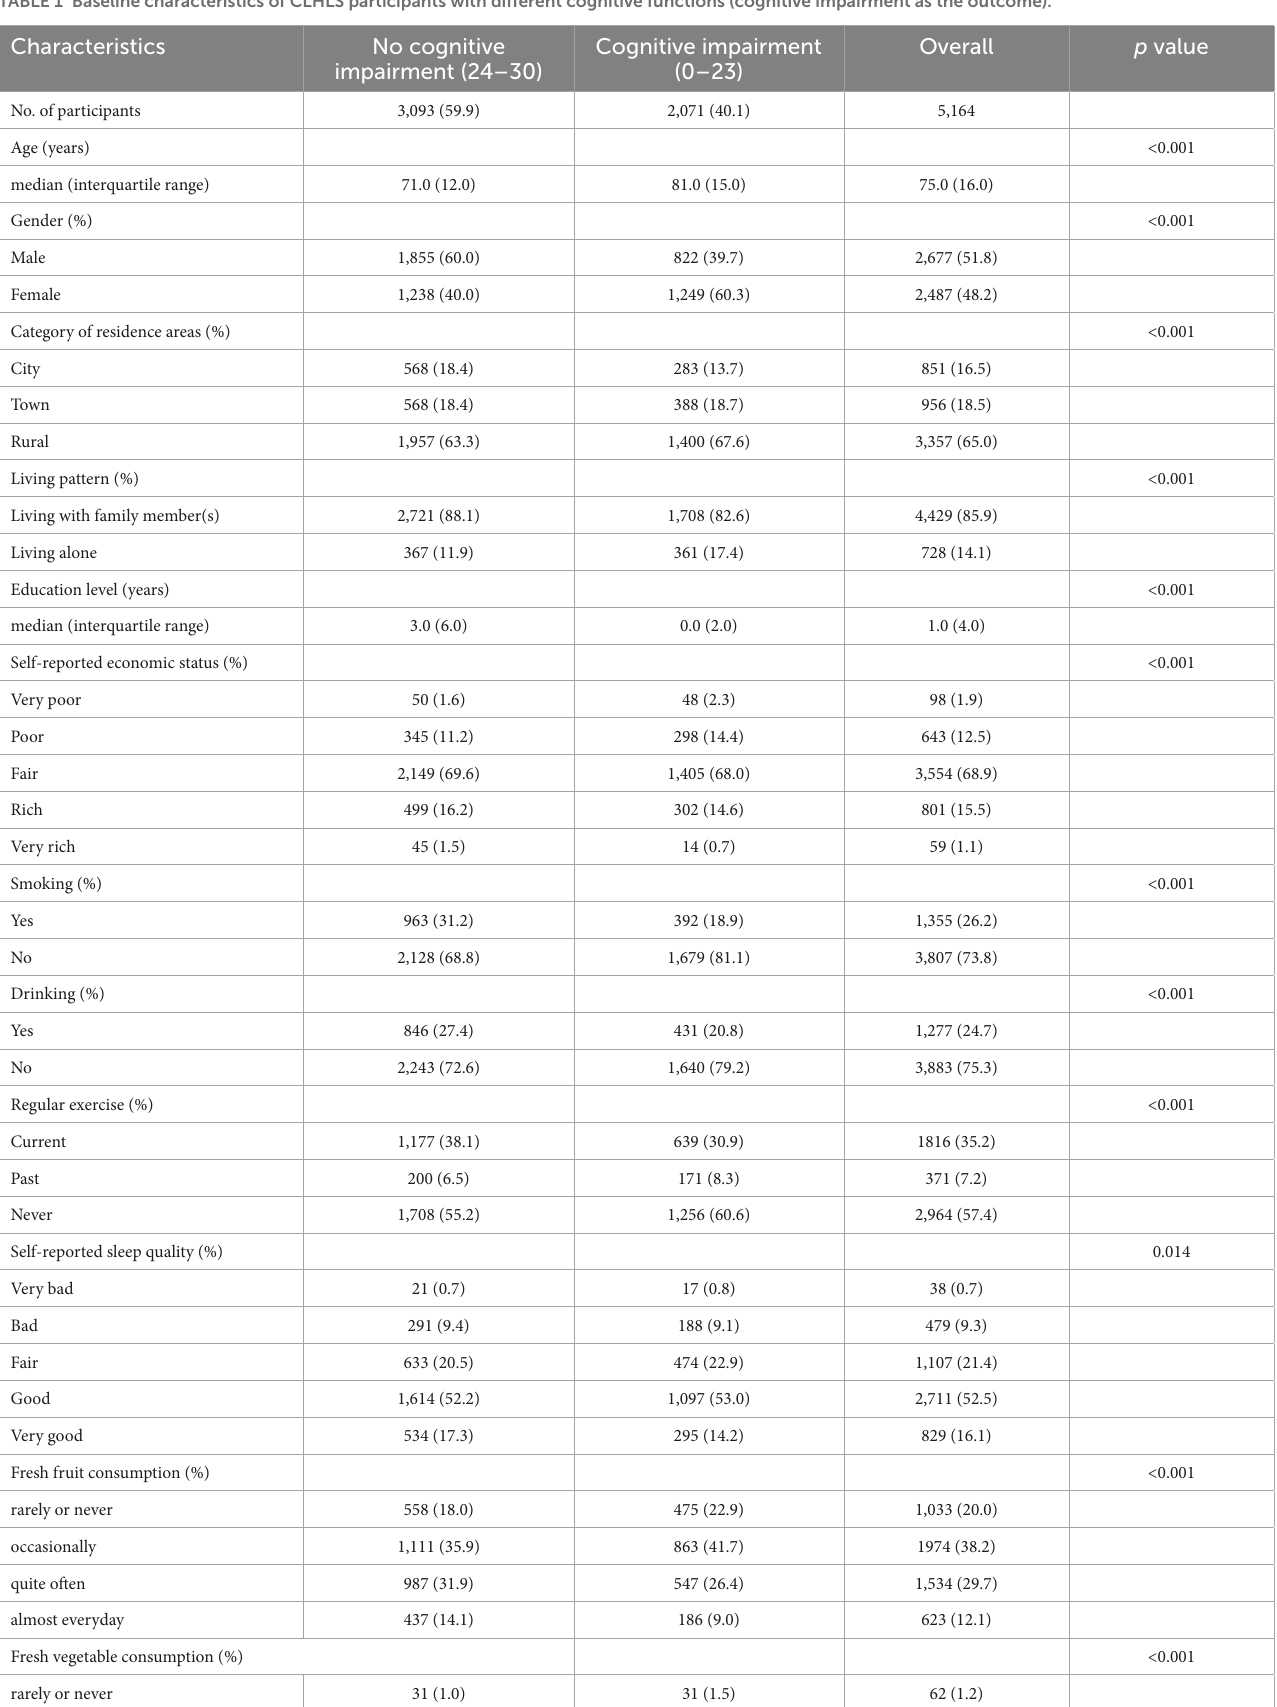
TABLE 1 Baseline characteristics of CLHLS participants with different cognitive functions (cognitive impairment as the outcome).